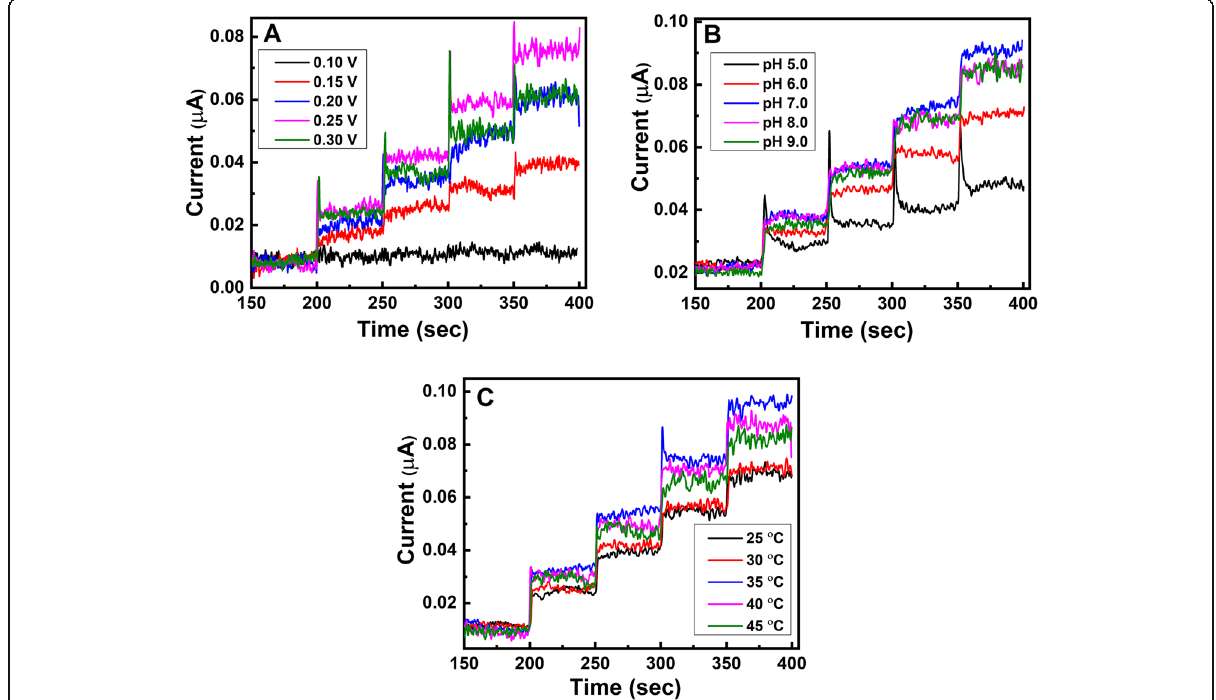
Fig. 4 a Amperometric current response of GCE / ErGO/MWCNTs/PPy for DA at different potentials, b at different pH values, and c at different temperatures in 0.1 M PBS (pH 7.0) containing 250 nM – 1000 nM